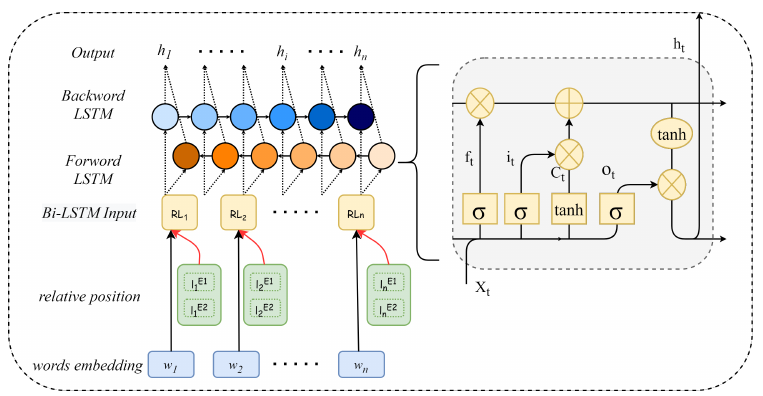
Figure 6. Bi-LSTM network structure.